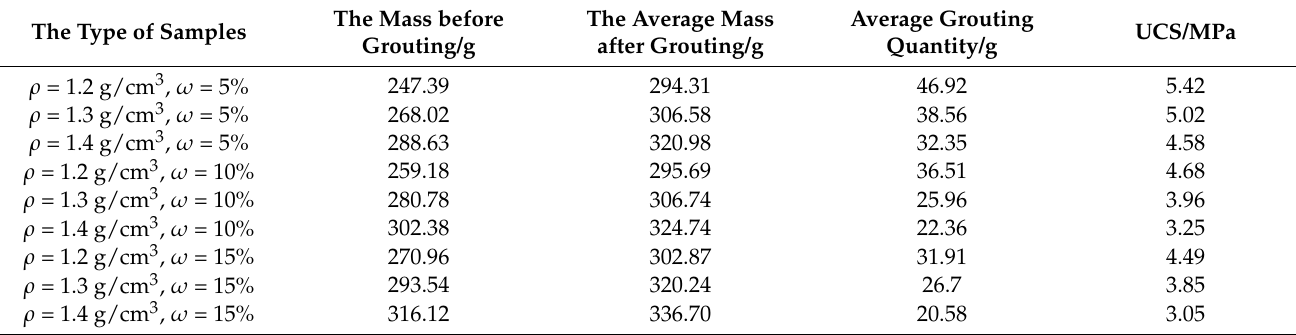
Table 6. Grouting quantity.